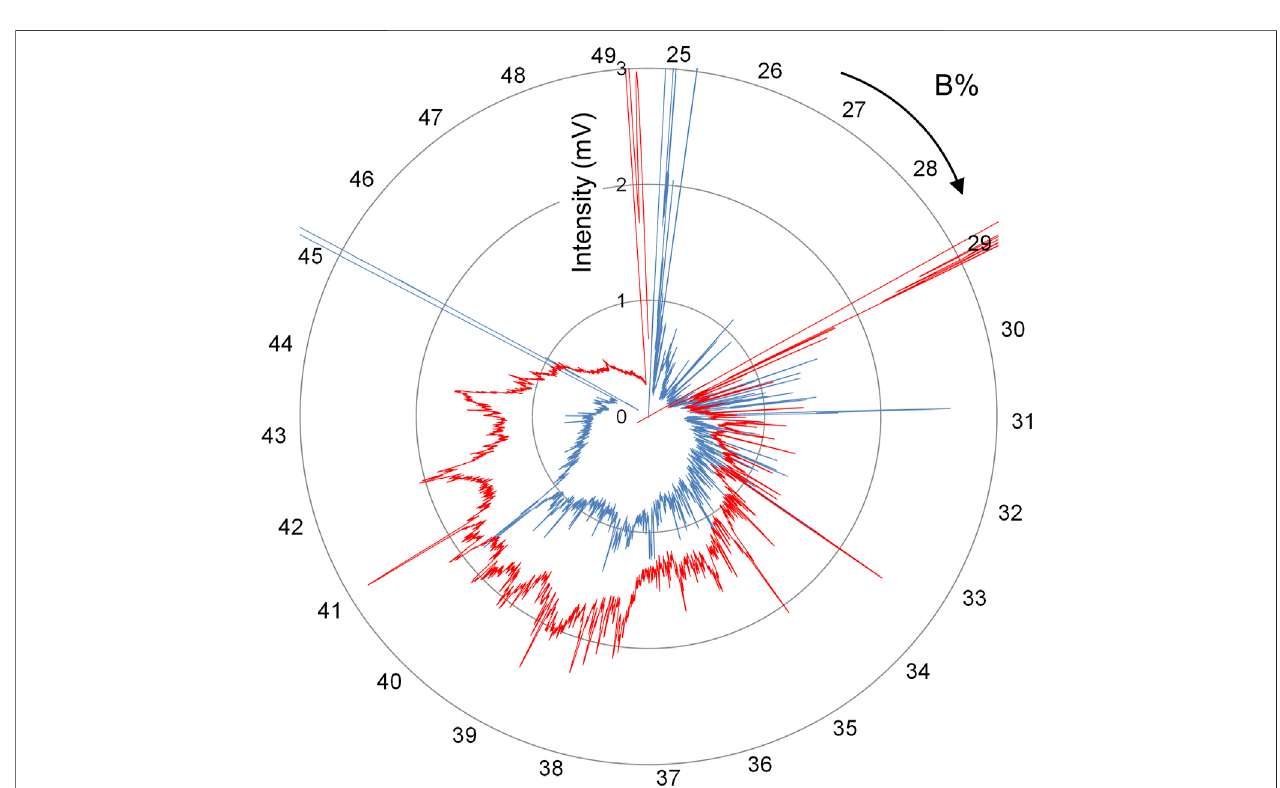
FIGURE 7 | Spiderweb chromatograms obtained by converting chromatograms depicted in Figure 6 .